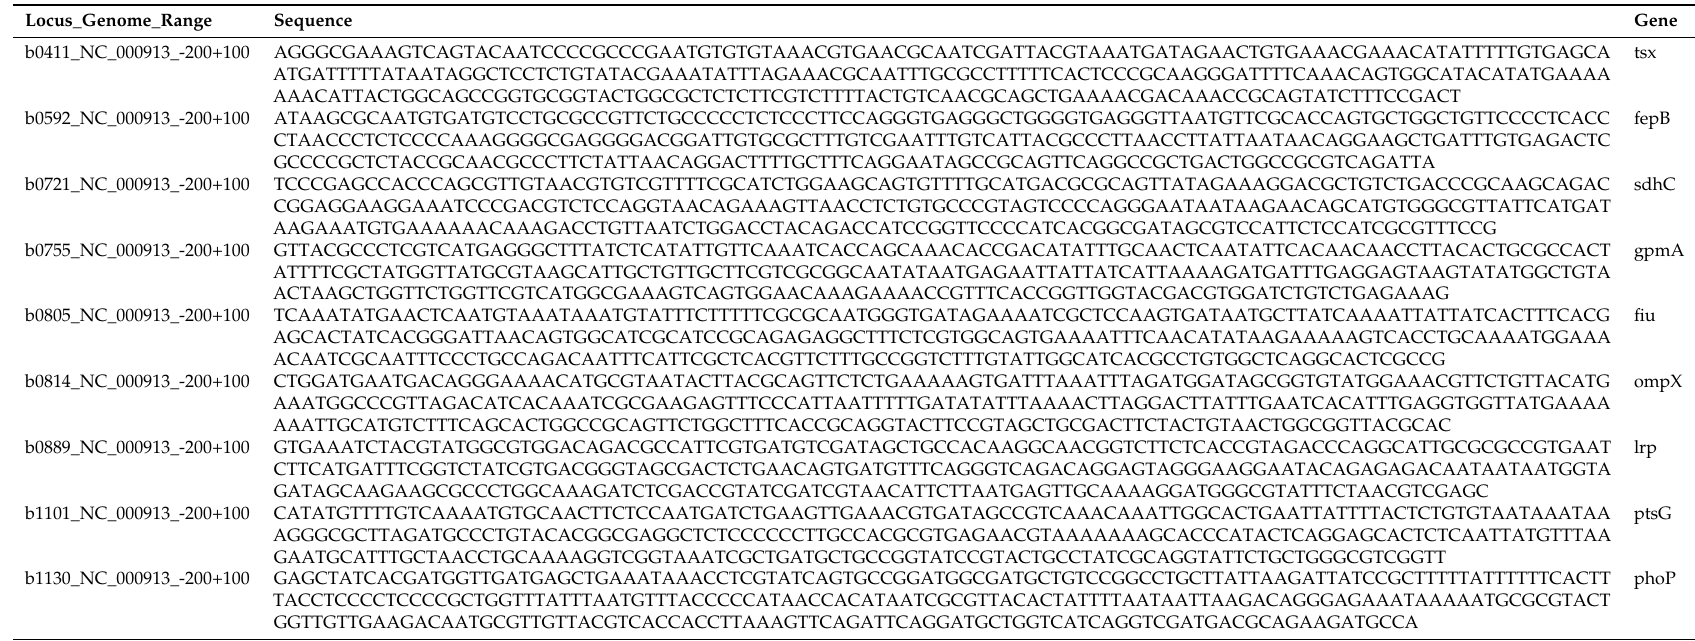
Table A5. genomic subsequences of NC_000913 -200+100 around start codon (continued in Table